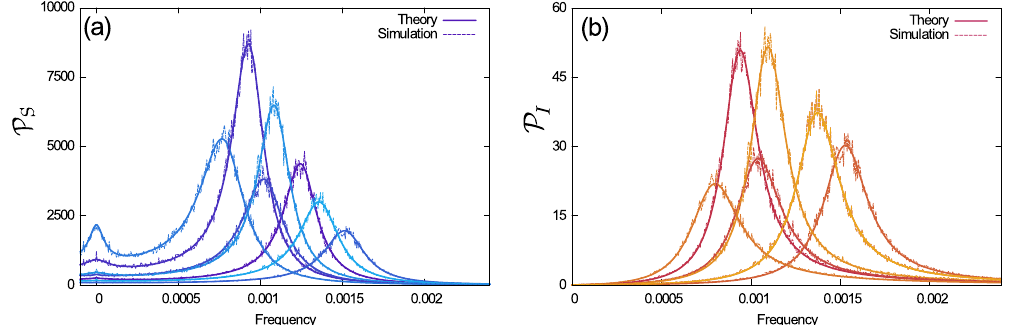
Figure 3. Power spectral densities of the fluctuations of (a) Susceptible and (b) Infected population for seven different examples of the model, generated as explained in more detail in the text. In all cases theory and simulations